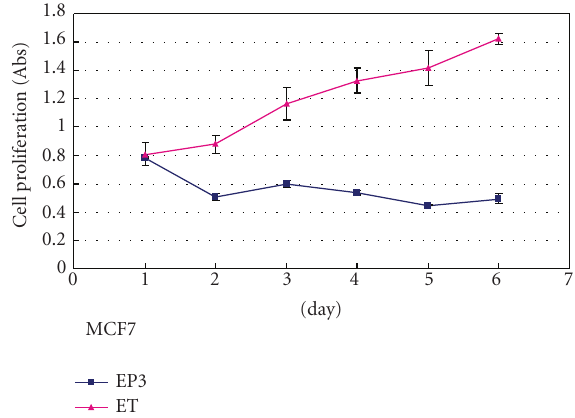
Figure 5: E ff ect of proliferation of cells transfected with di ff erent shRNA constructs. Rates of proliferation were determined as described in the text. Data are mean values from three replicates with error bar indicated. MCF-7 cells transfected with EP3 prolifer- ateare significantly more slowly than cells transfected with control plasmid ET. The wild type MCF-7 cells were not